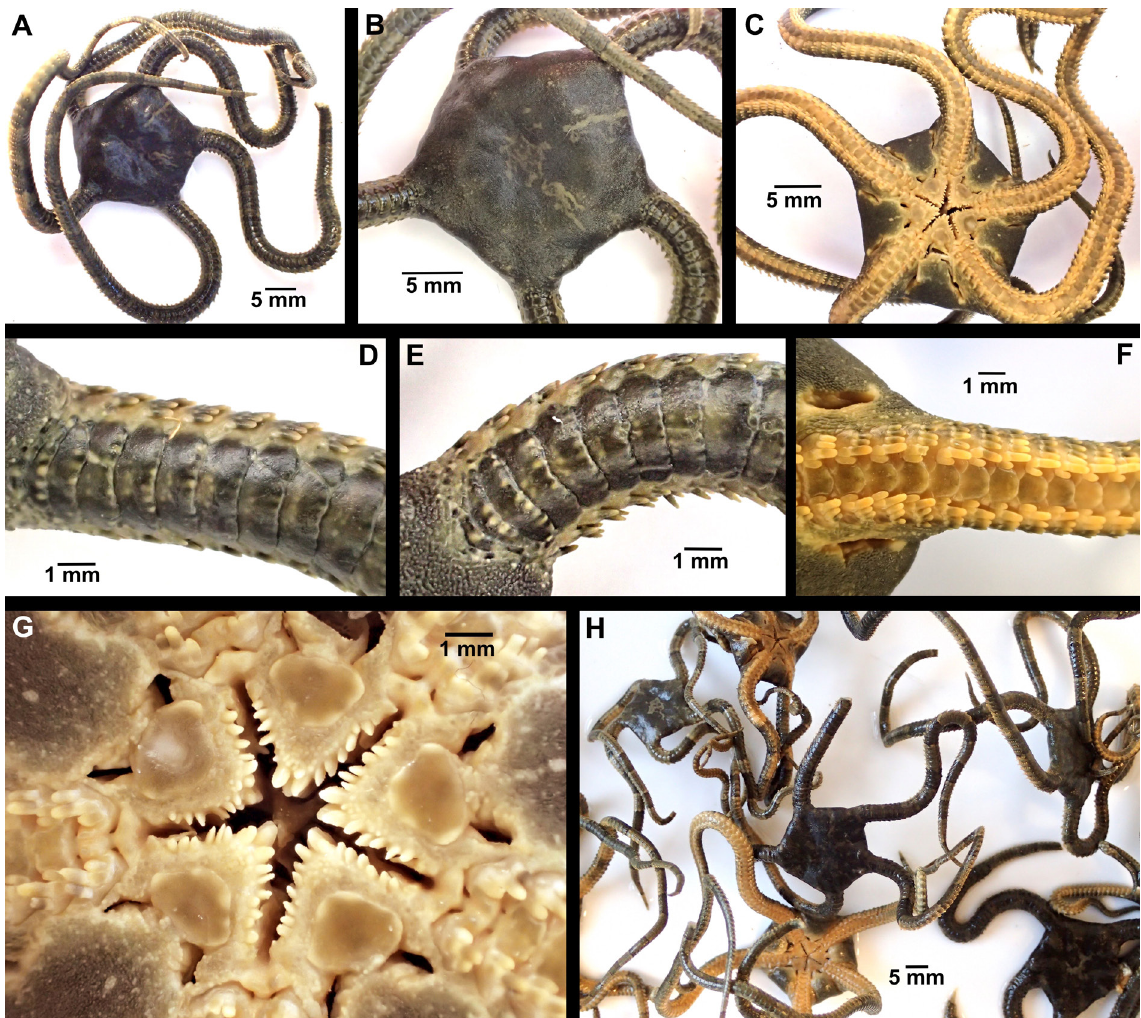
Fig. 7. Ophioderma africana sp. nov., digital images. A – G . Holotype (SMNH-Type-7484). A . Dorsal aspect. B . Dorsal disc. C . Ventral aspect. D – E . Two dorsal arms, note multiple dorsal arm plates on both. F . Ventral arm. G . Mouth. H . Some paratypes